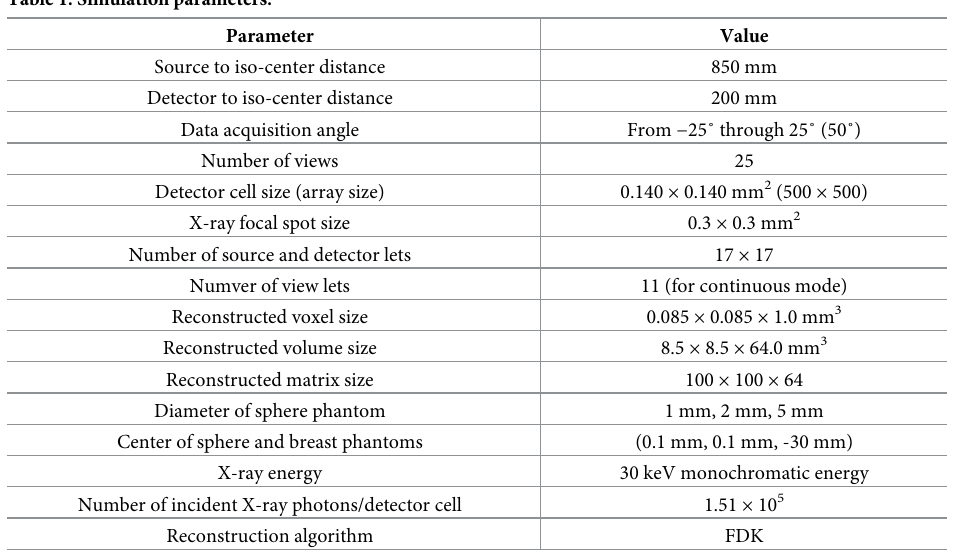
Table 1. Simulation